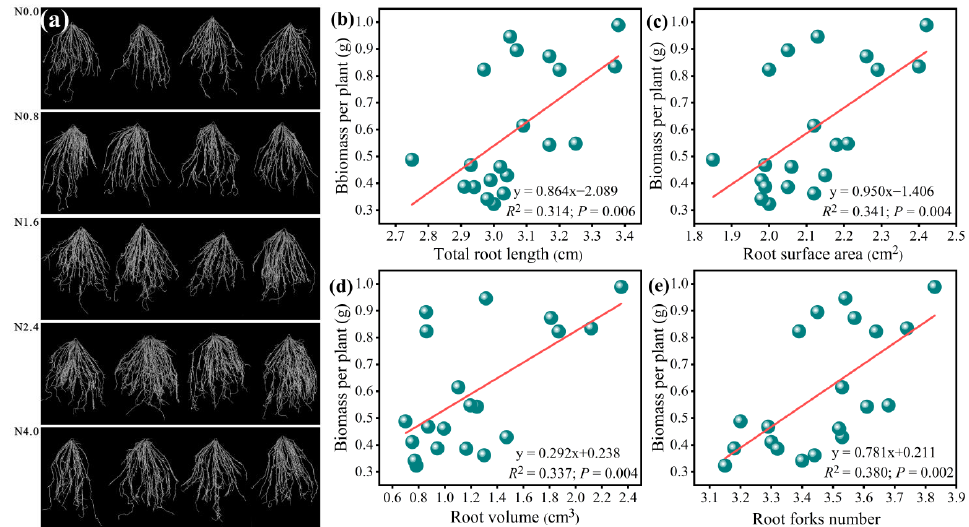
Figure 2. Root phenotype of A. mongolicum under various N addition gradients ( a ) and the relationship between these root morphological parameters and the total biomass. ( b )total root length, ( c ) root surface area, ( d ) root volume, ( e )root forks number.